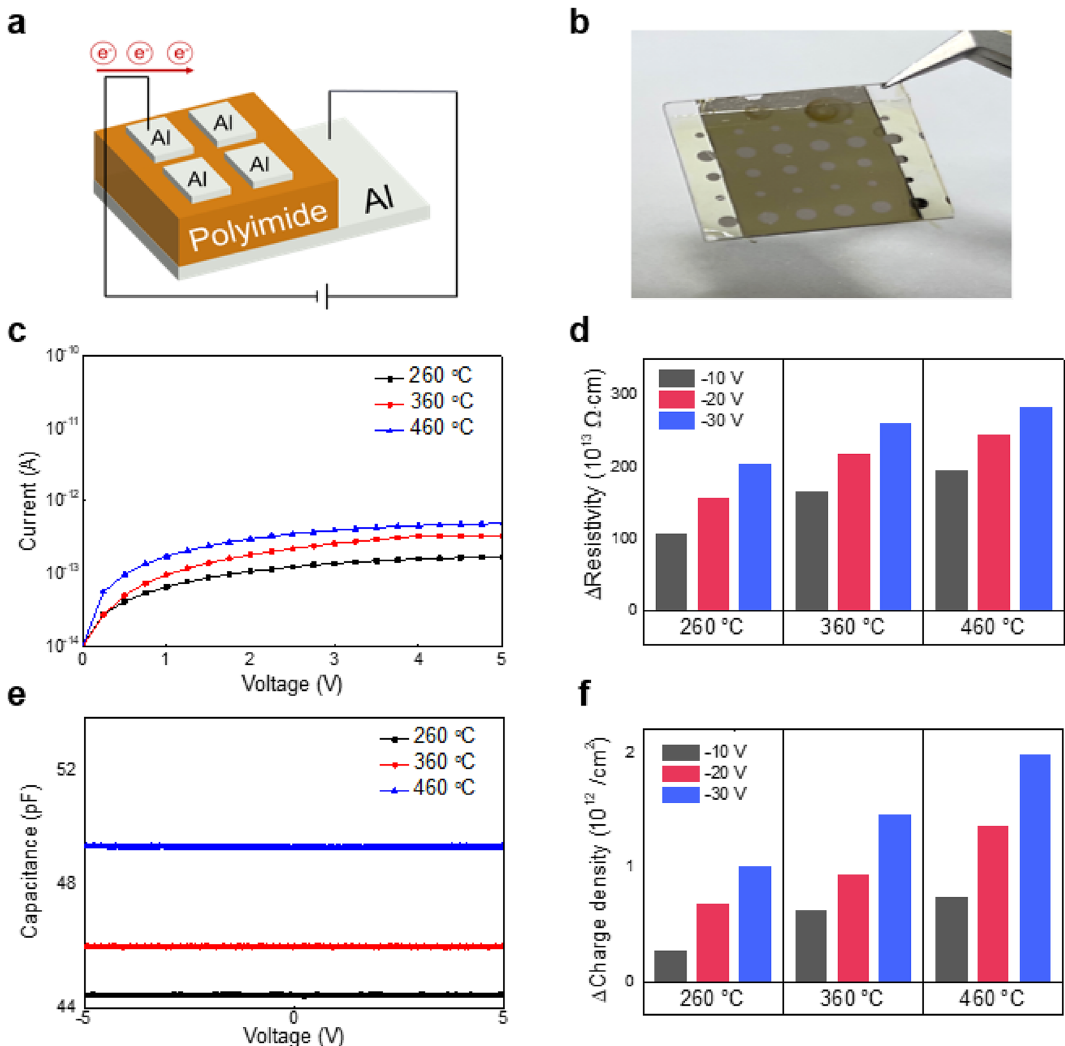
Figure 2. Electrical characteristics of MIM capacitors. ( a ) Structure of MIM capacitor (Al/PI(260 °C)/Al, Al/ PI(360 °C)/Al, Al/PI(460 °C)/Al). ( b ) Actual MIM capacitor used for measurement. ( c ) Initial I–V plot of MIM capacitors. ( d ) Change in resistivity of MIM capacitors under NBTS. ( e ) Initial C–V plot of MIM capacitors. ( f ) Change in charge density of MIM capacitors under